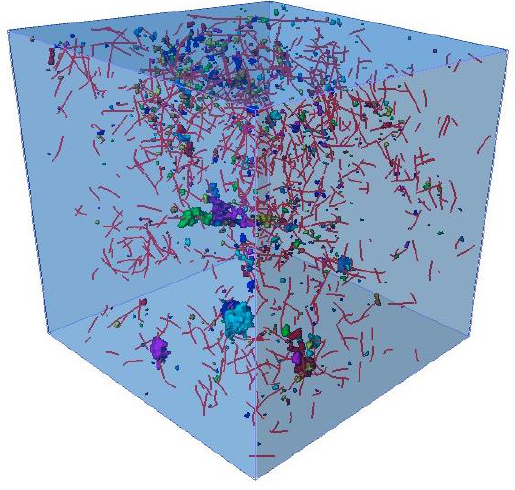
Figure 13. The distribution of crack and basalt fiber.